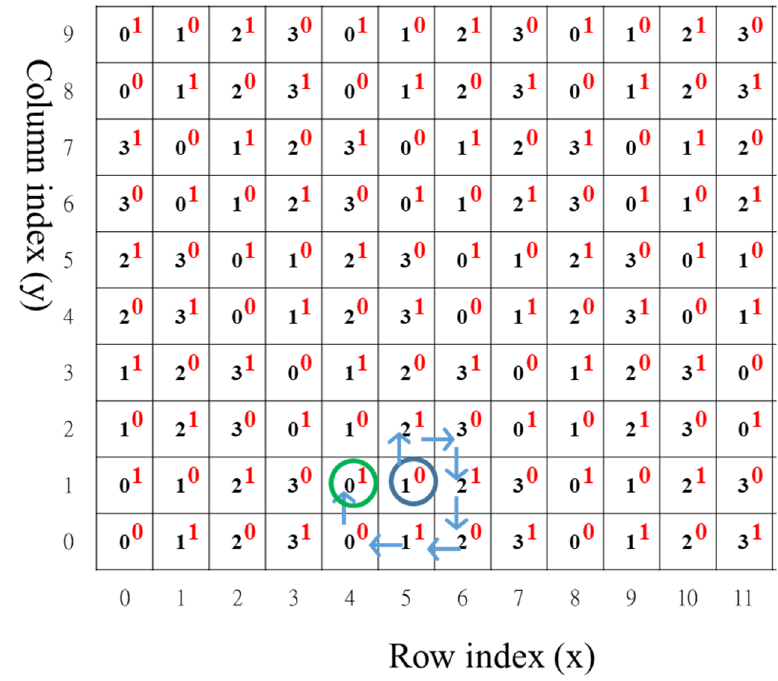
Figure 7. Watermark embedding example.